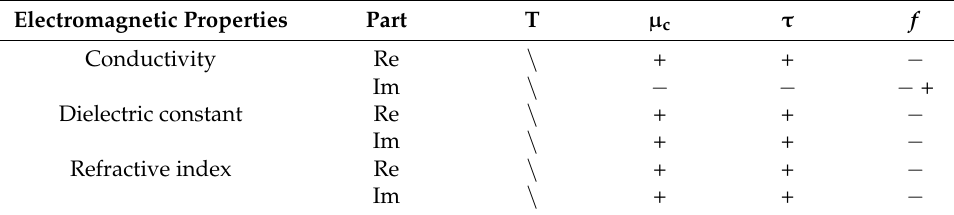
Table 2. The relationship between electromagnetic properties and influencing factors.